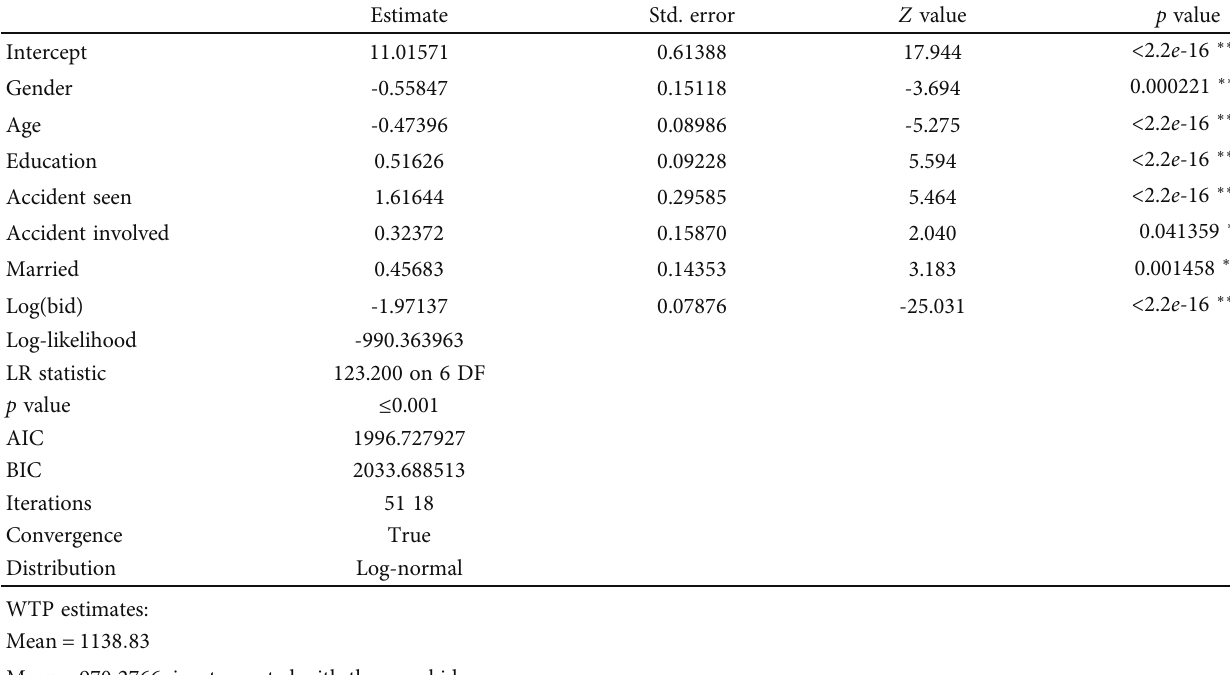
Table 9: Parameter estimates of the log-logistic model (source: